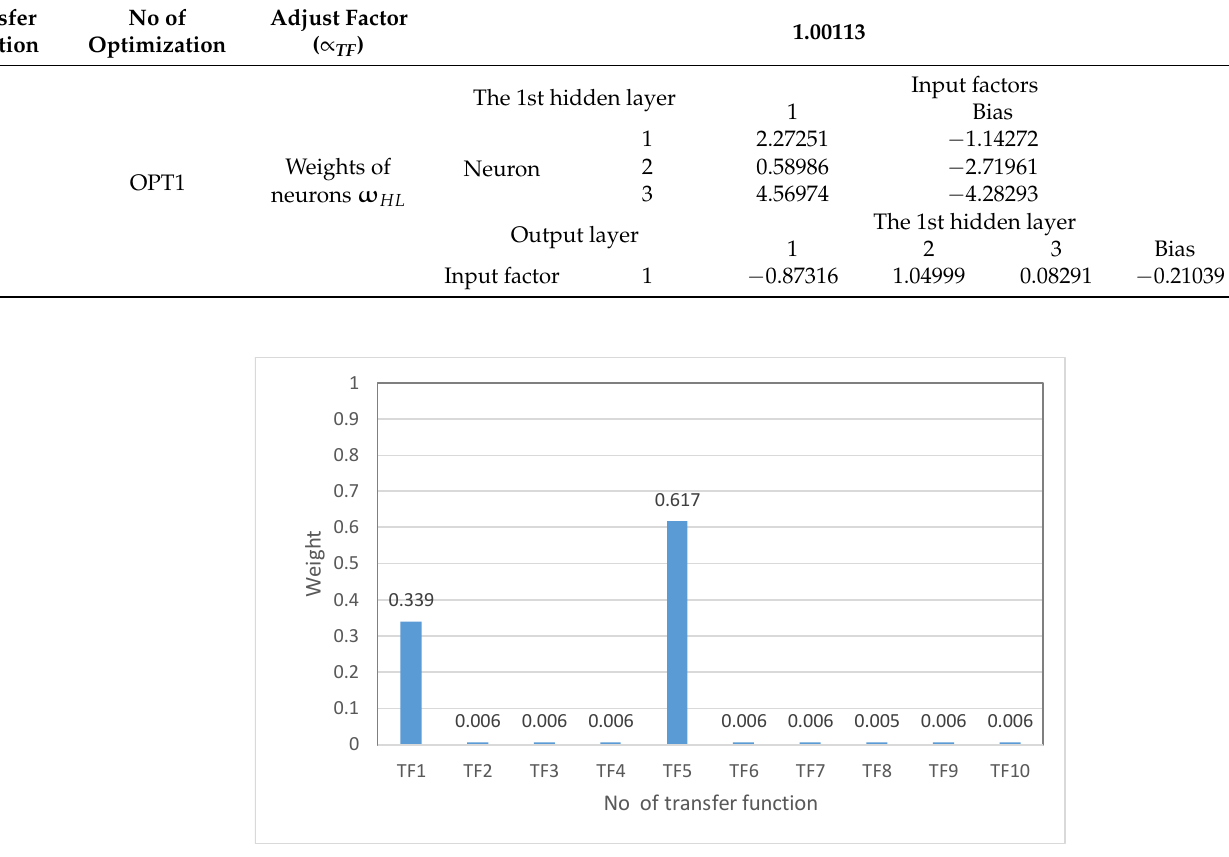
Figure 14. Summary of the transfer function weights for calculating the weighted average of inundation-depth estimates. Table 5. Summary for the appropriate calibrated parameters of the ANN_GA-SA_MTF model at the 500th VIOT grid.